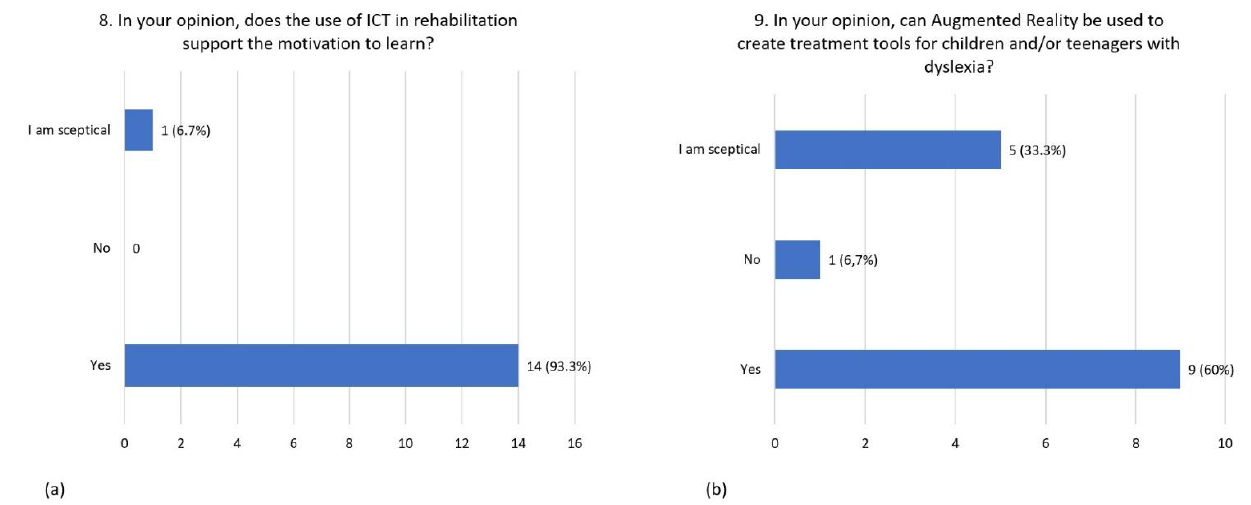
Figure 5. Distribution of responses to question 8 ( a ) and question 9 ( b ).